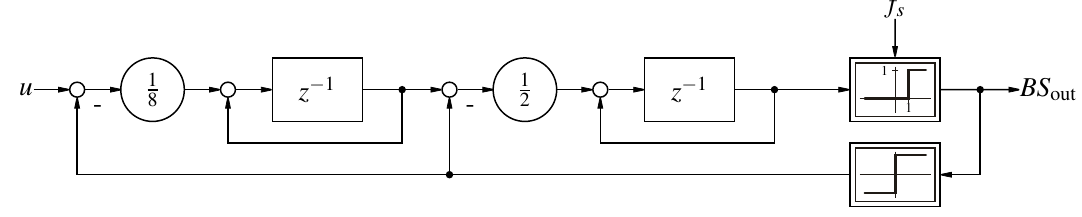
Figure 2. Utilized second order ∆Σ -M as proposed in [16].